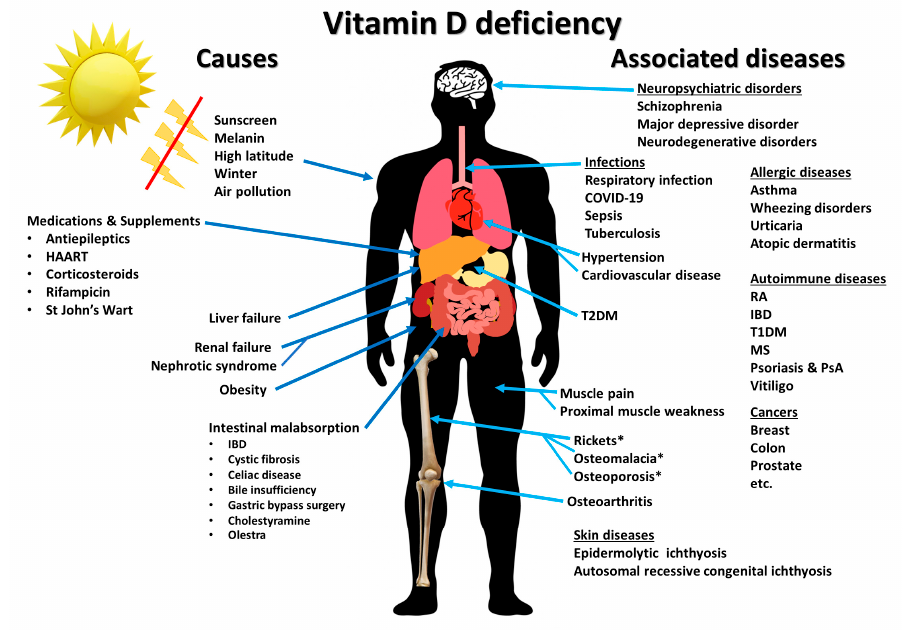
Figure 15. Summary of causes of vitamin D deficiency and diseases and disorders associated